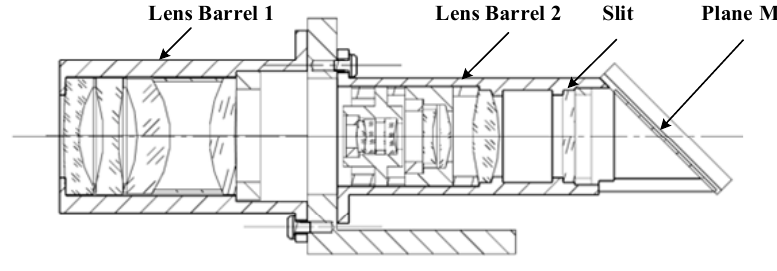
Figure 13. Optical–mechanical structure of the objective lens.